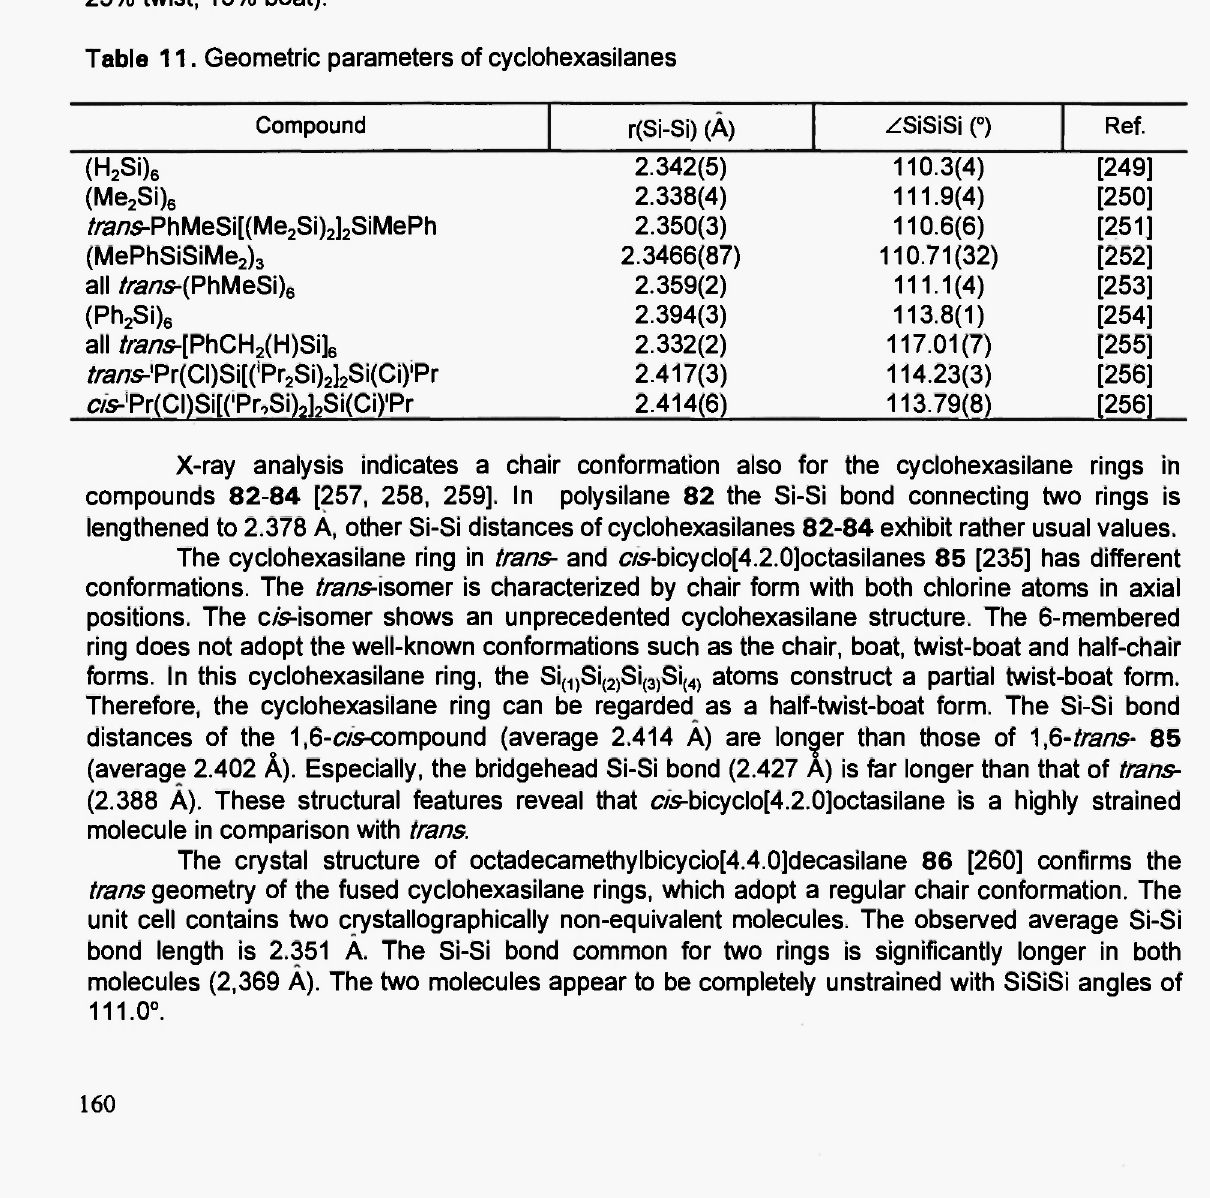
Table 11 . Geometric parameters of cyclohexasilanes